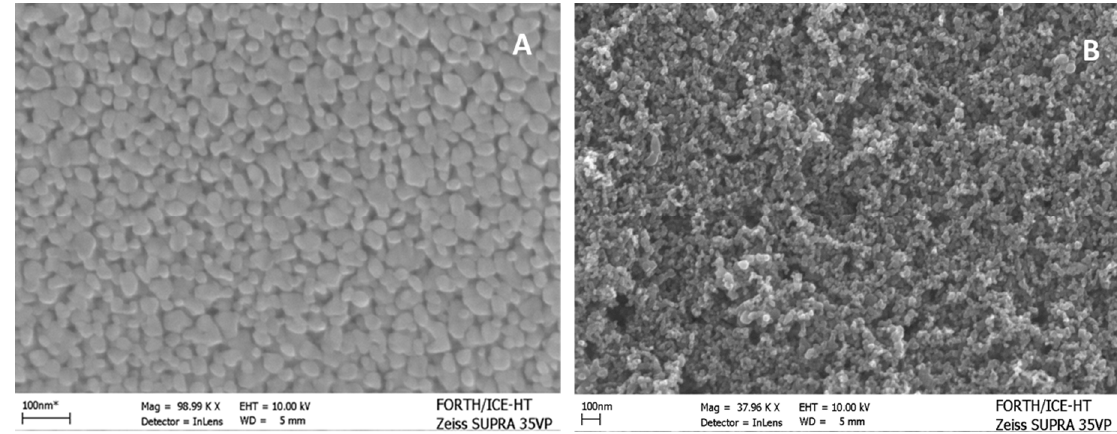
/ FTO ( A ) and a TiO 3